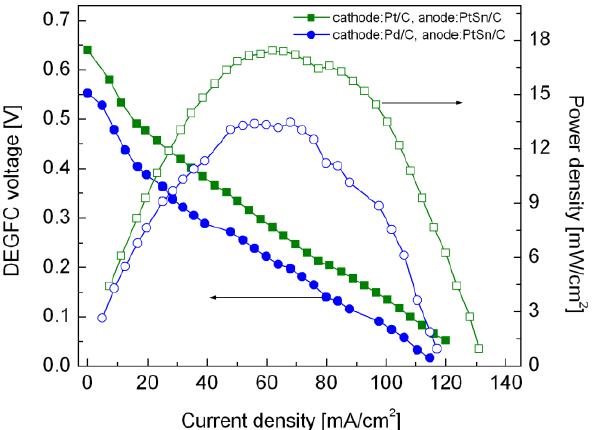
Figure 7. Polarization curves of the DEGFC equipped with Pd/C or Pt/C cathodes at 80 °C. Anodes: PtSn/C. Catalyst loading in all electrodes: 2 mg/cm 2 . Membrane: Nafion ® 117. EG concentration and flow rate: 1 M and 2 mL/min. Oxygen flow rate: 0.5 L/min without